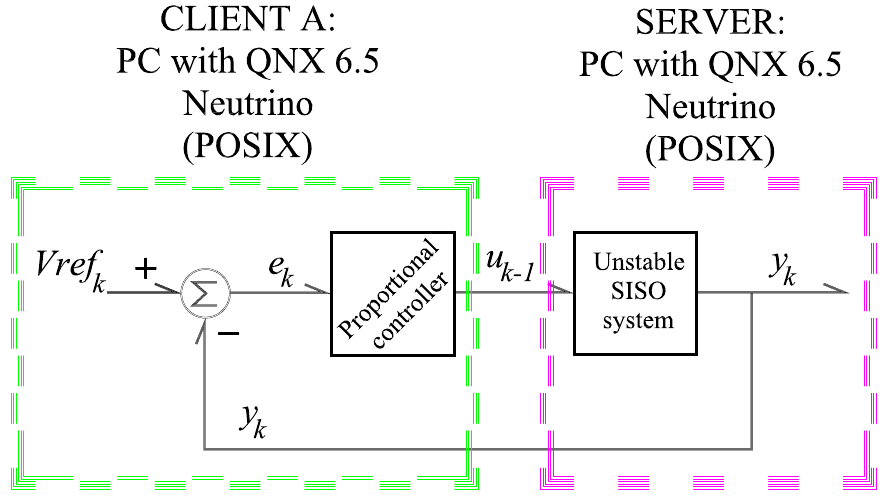
Figure 5. Block diagram of the control